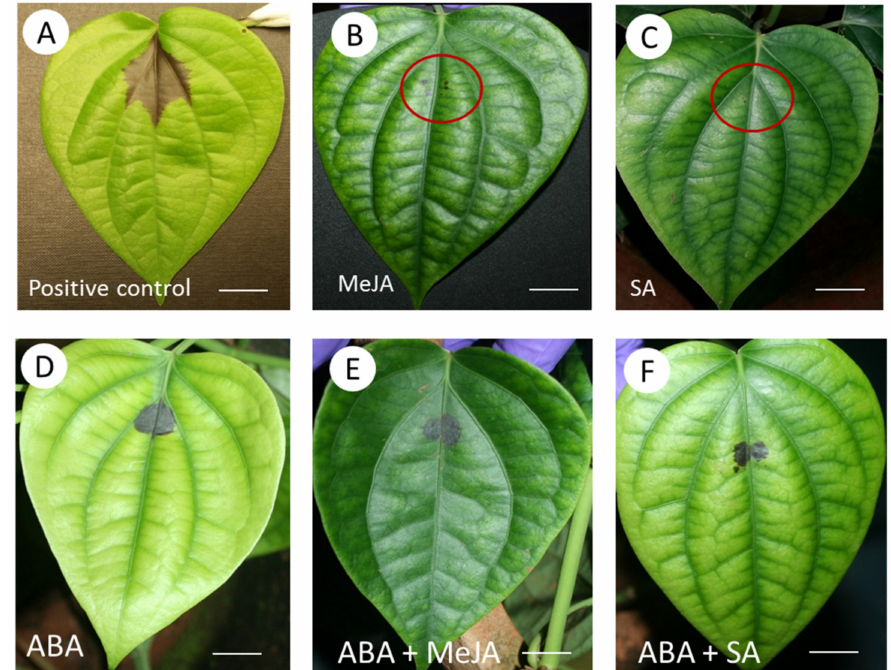
Figure 7. Phenotypes in Black Pepper ( Piper nigrum L.) leaves at 24 h challenged with Phytophthora capsici and treated with ( A ) water, ( B ) 0.5 mM methyl jasmonate (MeJA), ( C ) 1 mM salicylic acid (SA), ( D ) 100 µ M abscisic acid (ABA), ( E ) ABA + MeJA and ( F ) ABA + SA. The infection site is circled in red in some cases. Bar = 1